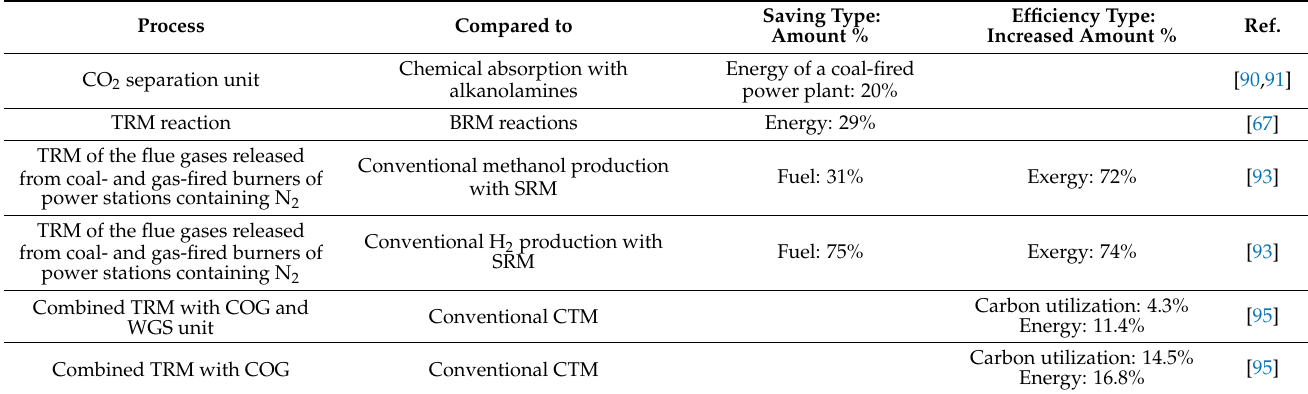
Table 6. Comparison of integrated TRM processes with conventional